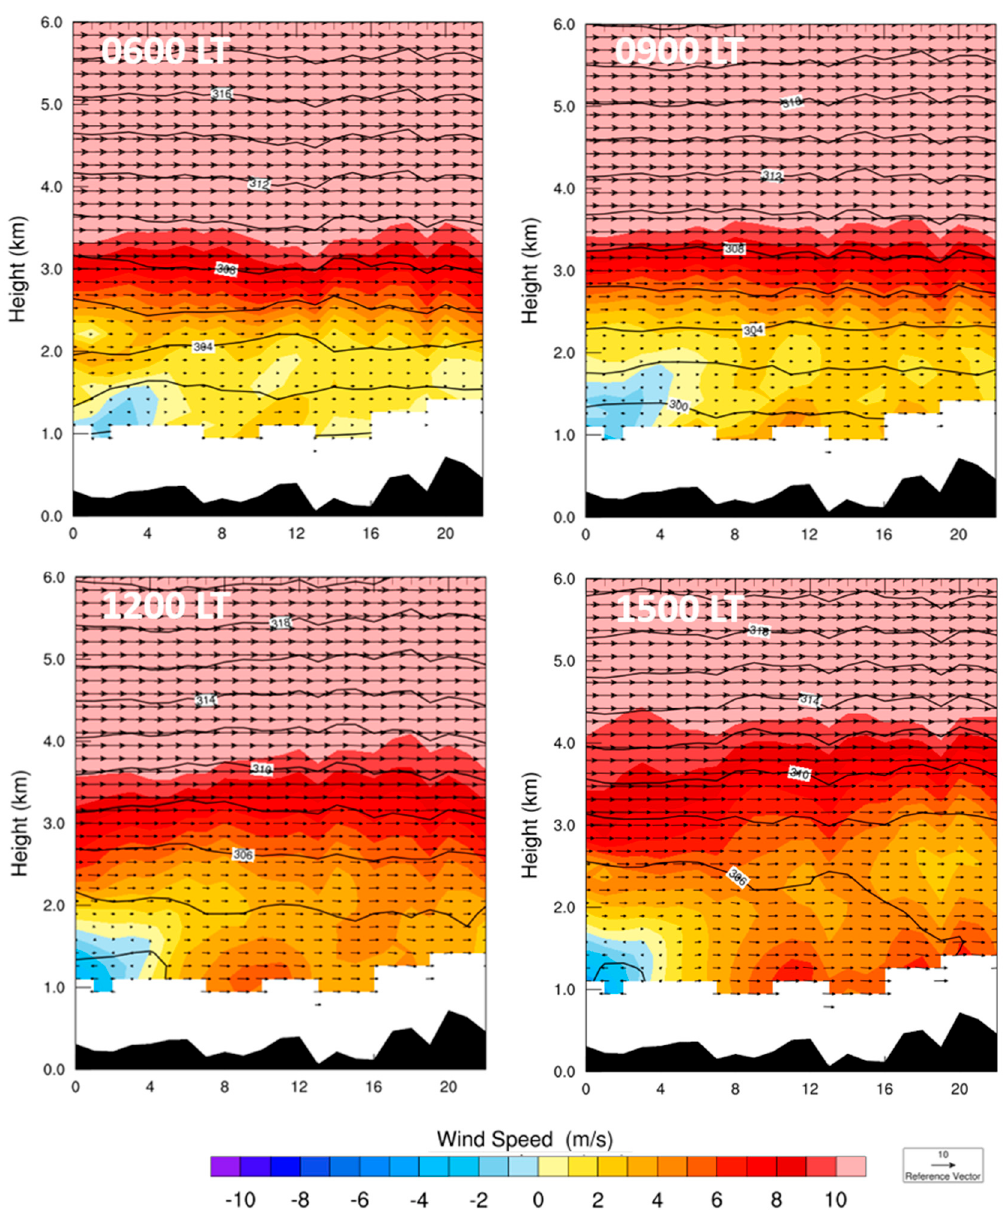
Figure 12. Along-valley vertical profiles of wind and potential temperature simulated in the 1.33 km domain for non-event day 18 August. Wind vectors indicate wind in the x - z plane. Wind speed is the u-component of the wind; negative values indicate easterly flow. The study area is located in cells 7–10 on the x -axis. Only the lowest 6 km are shown.